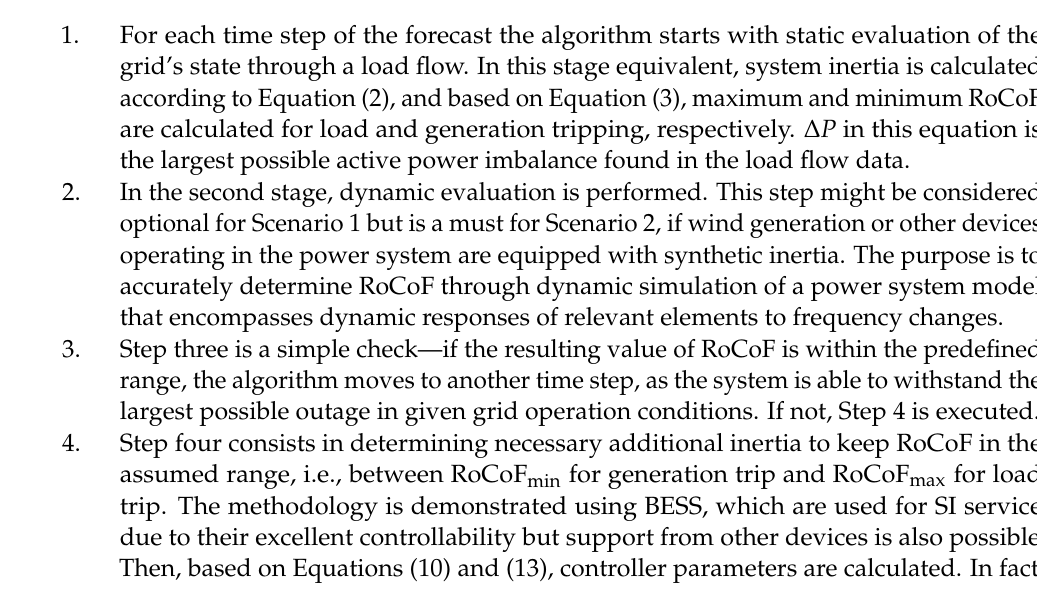
Figure 6. Methodology for frequency stability assessment and synthetic inertia provision.